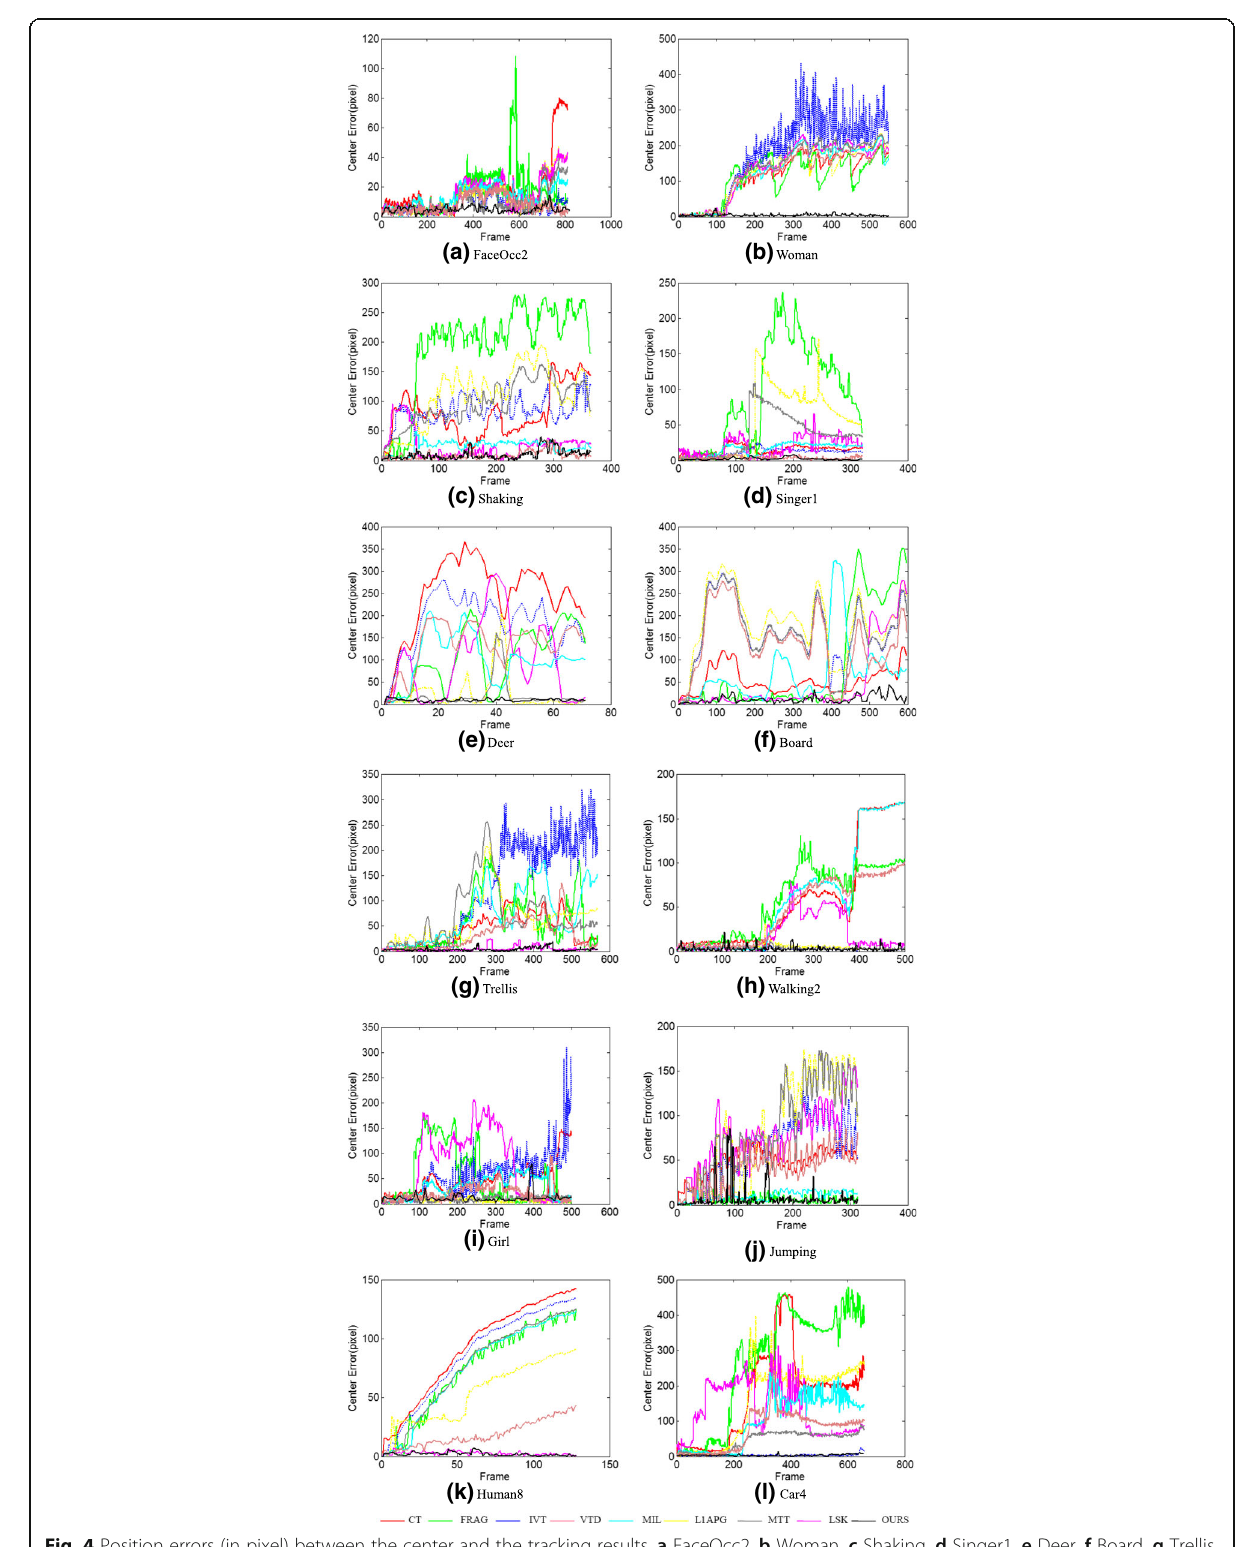
Fig. 4 Position errors (in pixel) between the center and the tracking results. a FaceOcc2. b Woman. c Shaking. d Singer1. e Deer. f Board. g Trellis. h Walking2. i Girl. j Jumping. k Human8. l